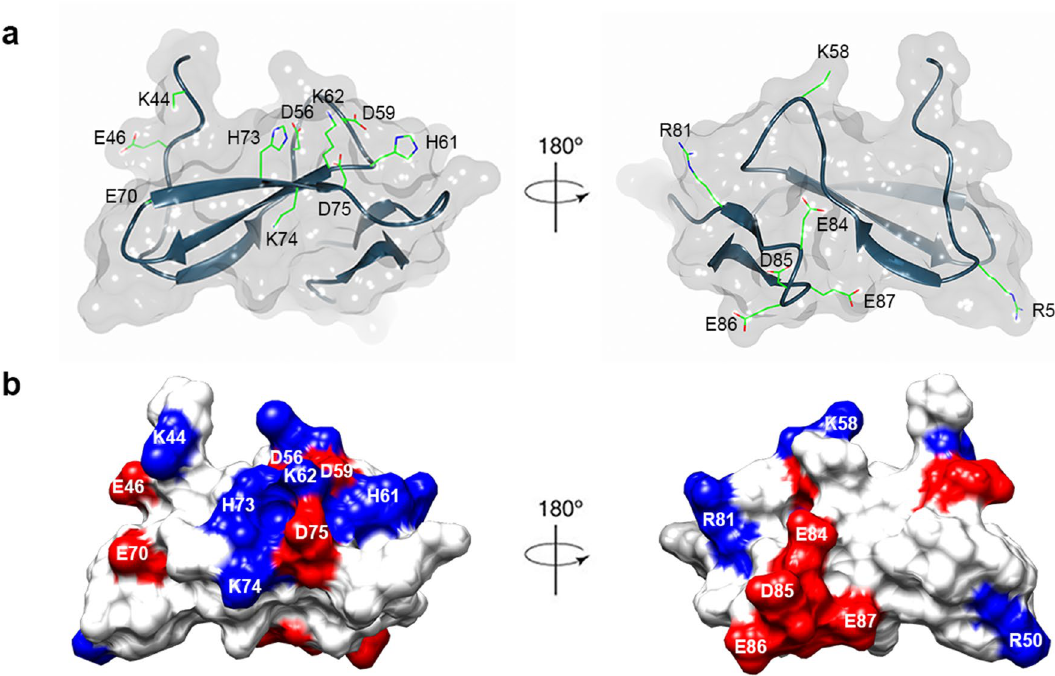
Figure 1. The 17 solvent-accessible, polar, and charged amino acid residues selected for mutagenesis. ( a ) All the selected residues were mapped and shown as cylinder models on the ribbon diagram of rDer p 23 chain A. ( b ) Surface diagram of rDer p 23 with selected residues highlighted. Positively charged and negatively charged residues are colored in blue and red, respectively. Figures were generated using the program CCP4mg 36 and the program Chimera 37 ,